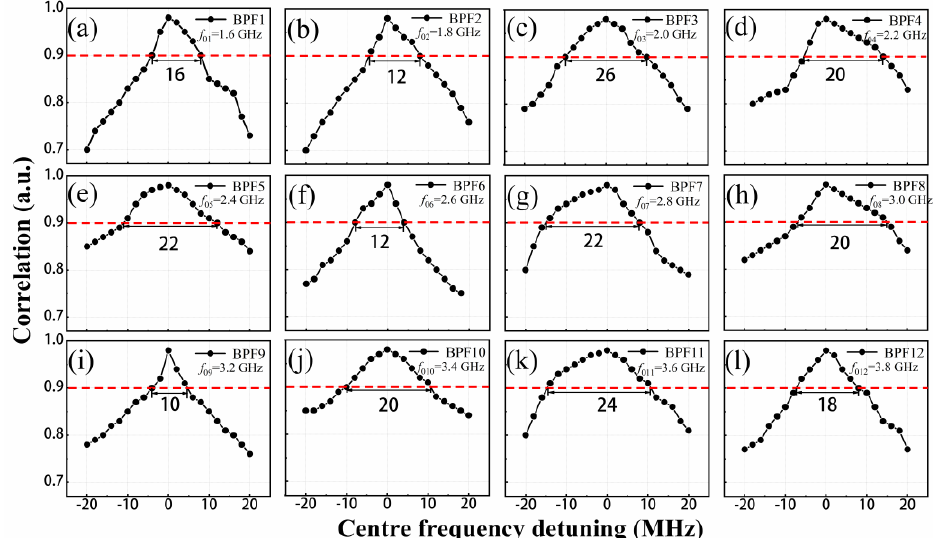
Figure 7. Effects of mismatch of centre frequency of BPFs on correlation coefficient. The centre frequency of BPFs is (a) 1.6 GHz, (b) 1.8 GHz, (c) 2.0 GHz, (d) 2.2 GHz, (e) 2.4 GHz, (f) 2.6 GHz, (g) 2.8 GHz, (h) 3.0 GHz, (i) 3.2 GHz, (j) 3.4 GHz, (k) 3.6 GHz, (l) 3.8 GHz.